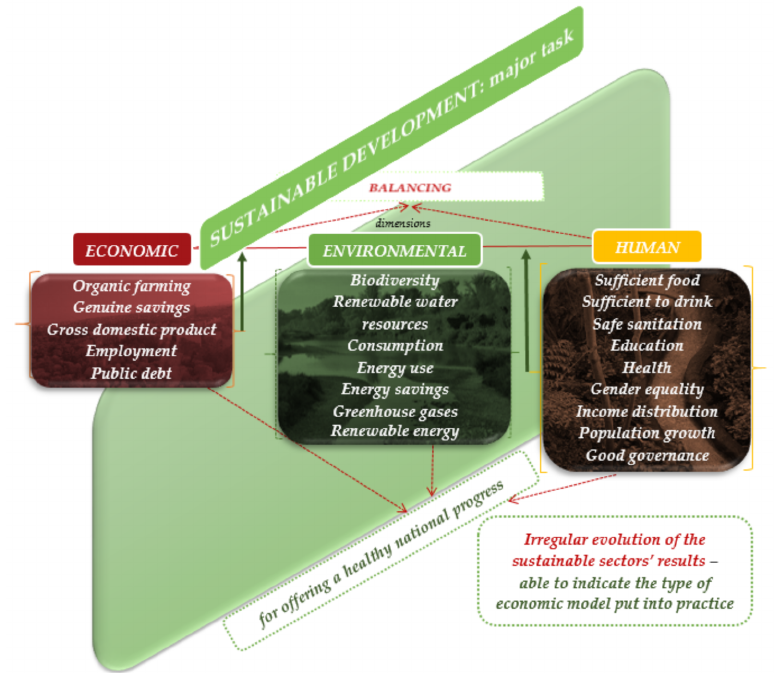
Figure 1. Conceptual framework for analyzing the relation among the environmental, social, and economic dimensions of sustainable development. Source: Authors’ representation following the approach of the SSI